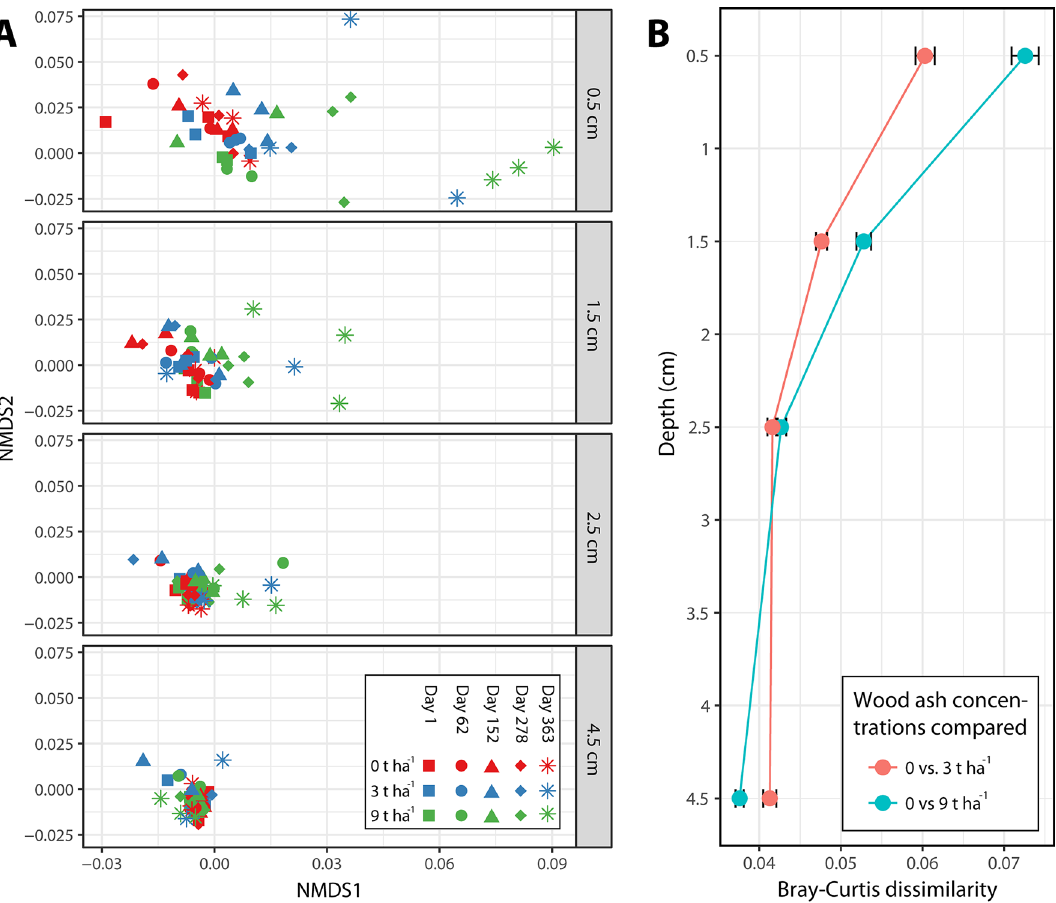
Figure 2. Bray–Curtis dissimilarity of prokaryotic communities across wood ash concentrations, time after ash application and depth below soil surface. ( A ) NMDS projection of dissimilarities between samples separated into depths (stress = 0.11). ( B ) Average Bray–Curtis dissimilarity between prokaryotic communities of unamended soil samples compared to samples applied with ash doses of 3 and 9 t ha −1 , respectively (0 vs. 3 t ha −1 and 0 vs. 9 t ha −1 ), within each soil depth. Figure was created in R v. 1.0.153 (www.R-proje ct.org) and GIMP v. 2.8.22 (https